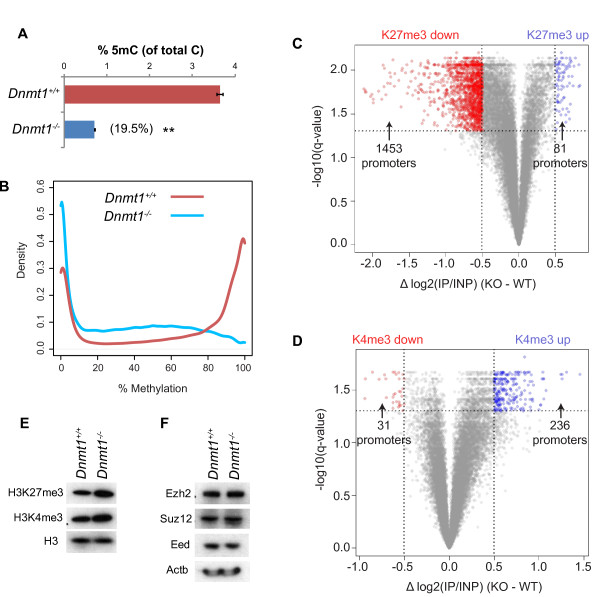
H3K27me3 and H3K4me3 mapping at gene promoters in DNA hypomethylated somatic cells. (A) Global quantification of the 5 mC base by HPLC. Values are 5 mC as a percentage of total C in Dnmt1+/+ and Dnmt1-/- MEFs. Error bars represent standard error of the mean. **P <0.001 by t-test. (B) Density plots showing CpG methylation levels in Dnmt1+/+ and Dnmt1-/- MEFs as measured by RRBS. (C, D) Volcano plots of all promoter H3K27me3 (C) and H3K4me3 (D) ChIP data measured by promoter microarray (ChIP-chip). Difference in normalized average promoter values between Dnmt1+/+ and Dnmt1-/- MEFs (Δlog2(IP/INP)) is plotted against q-value (P-value (two-tailed t-test) corrected for multiple testing by Benjamini-Hochberg method). Promoters that have a difference of <-0.5 or >0.5 and a q-value <0.05 are defined as significantly different. Red points indicate promoters with reduced H3K27me3/H3K4me3 in Dnmt1-/- MEFs (H3K27me3/H3K4me3 down) and blue indicate promoters with increased H3K27me3/H3K4me3 in Dnmt1-/- MEFs (H3K27me3/H3K4me3 up). (E, F) Western blot for histone modifications (E) and core PRC2 components (F) in Dnmt1+/+ and Dnmt1-/- MEFs. mC, methyl-cytosine. KO, knock-out, Dnmt1-/- MEFs. WT, wild-type, Dnmt1+/+ MEFs.